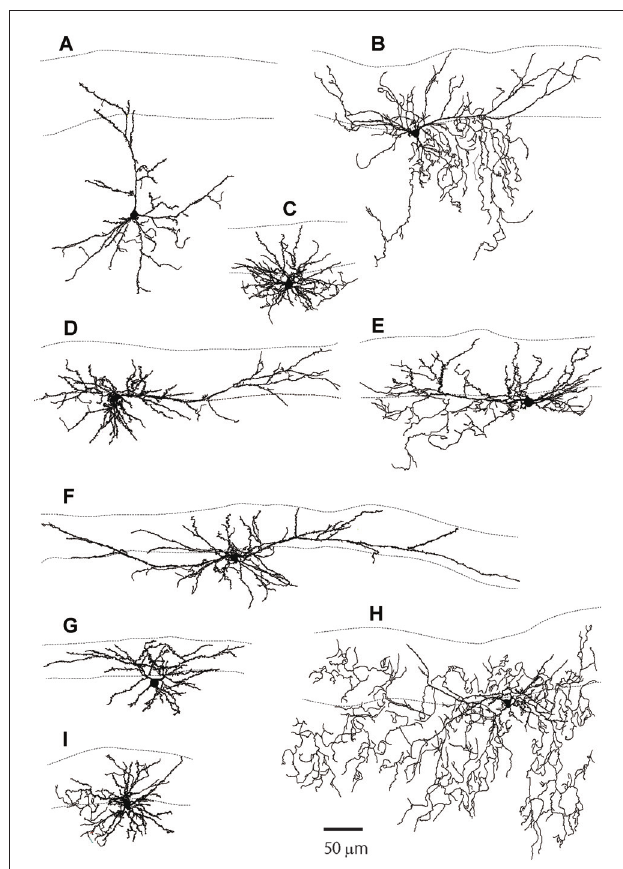
FIGURE 2 | The reconstructed dendritic trees of L2MN PyL neurons, NPy neurons and a typical pyramidal neuron. (A) A typical pyramidal neuron with its apical dendrite running towards the pia. (B,D–F,I) Examples of PyL neurons with “apical” dendrites running parallel to the pia. (C,G,H) Examples of NPy neurons with dendrites extended in many directions, but with a thick primary dendrite that was defined as the apical dendrite for these cells. The two dotted lines in each figure show the pia surface and the border between L1 and L2,